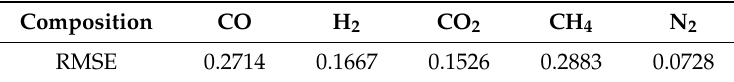
Table 6. Results of sum squared deviation method.